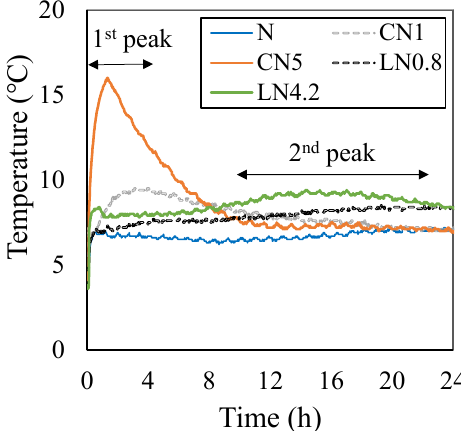
Figure 5. Temperature history (up to 24 h).